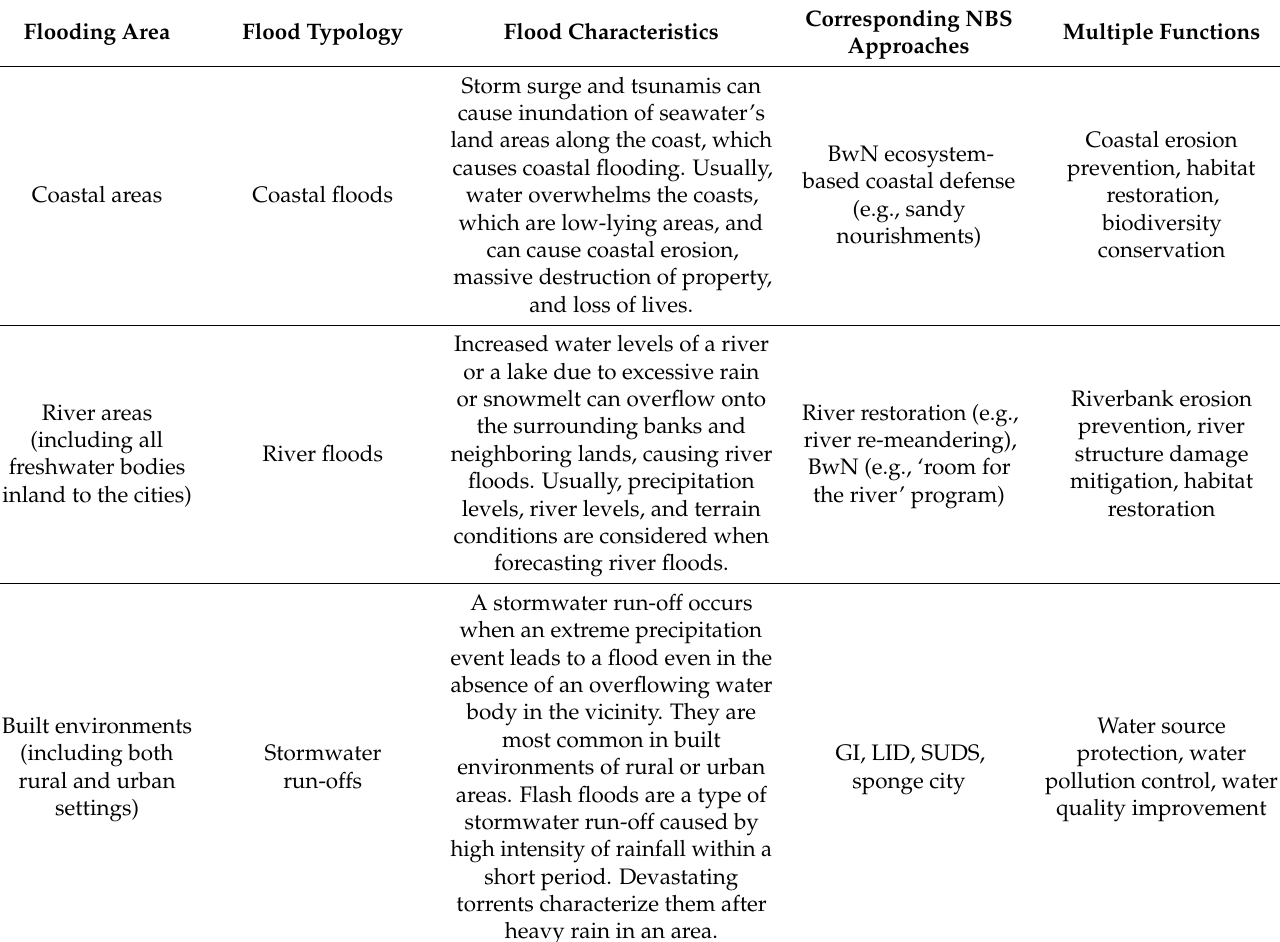
Table 1. Classification of different flooding areas and corresponding NBS